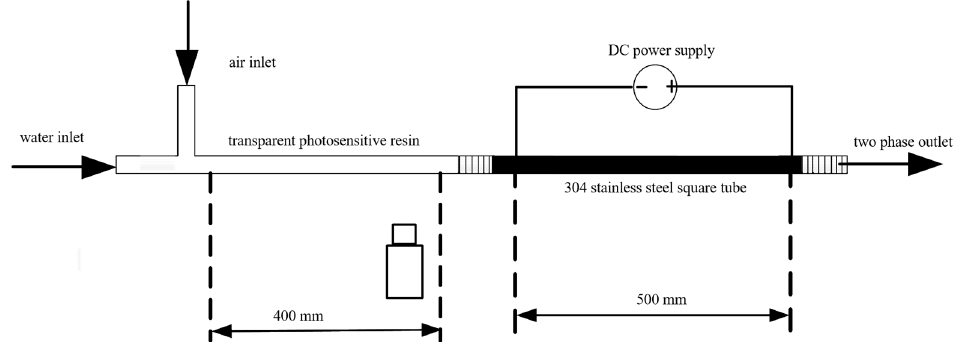
Figure 2. Schematic diagram of the experimental section.